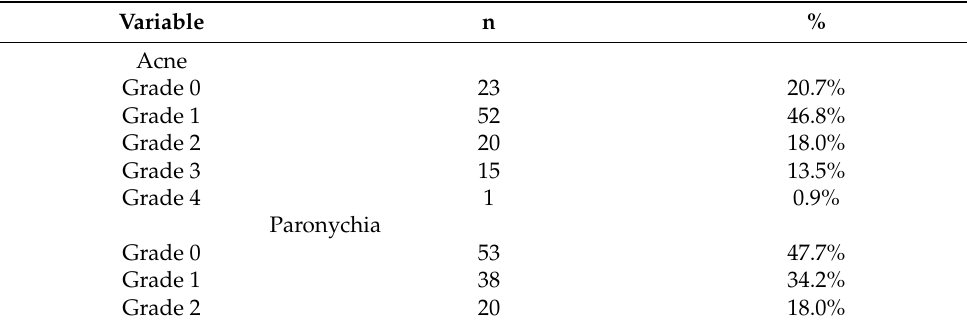
Table 3. Anti-EGFR Skin Reactions (N =